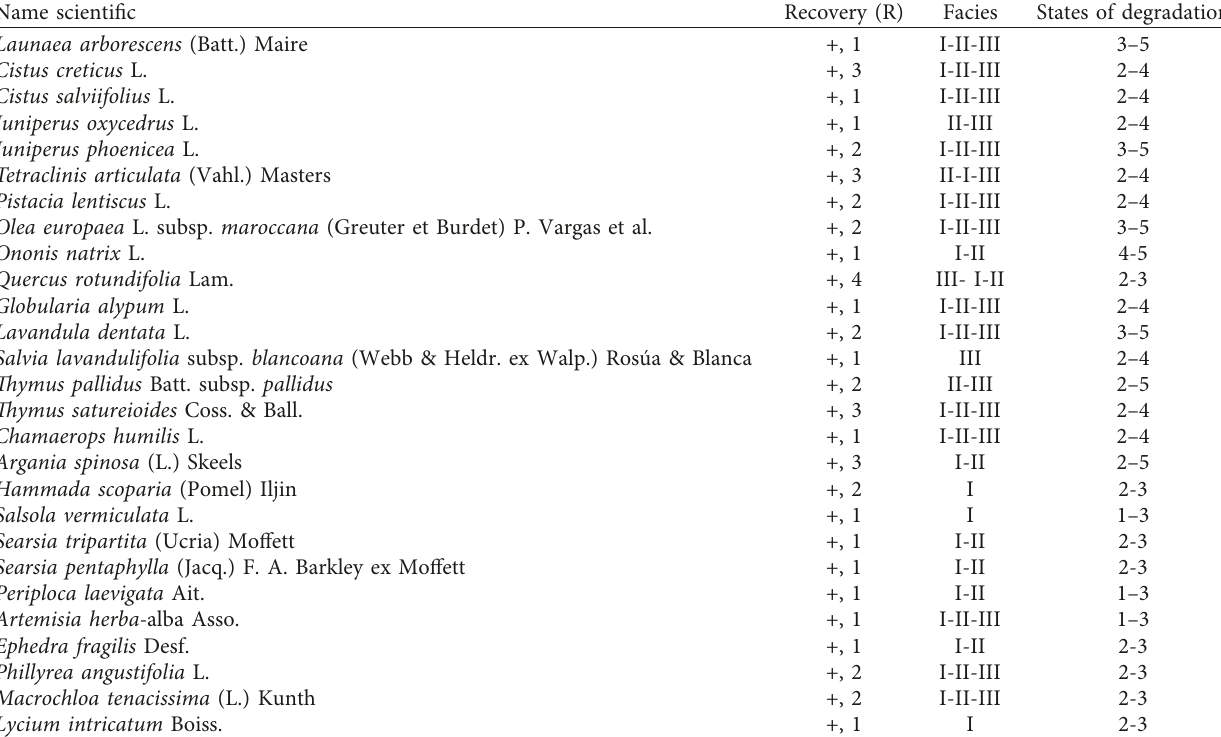
Table 2: List of potentially exploitable AMPs within the Bigoudine